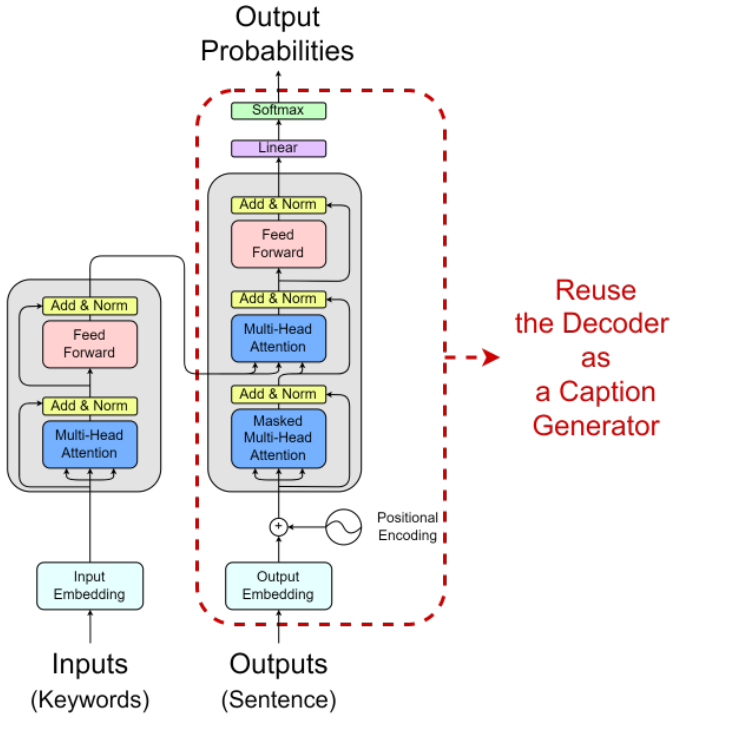
Figure 3. Pre-training model architecture.